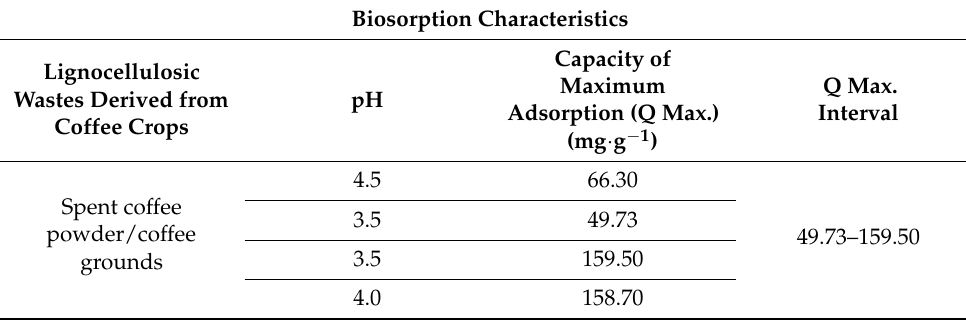
Table 13. Maximum adsorption capacity of selected coffee wastes without modification. Own compilation based on literature data